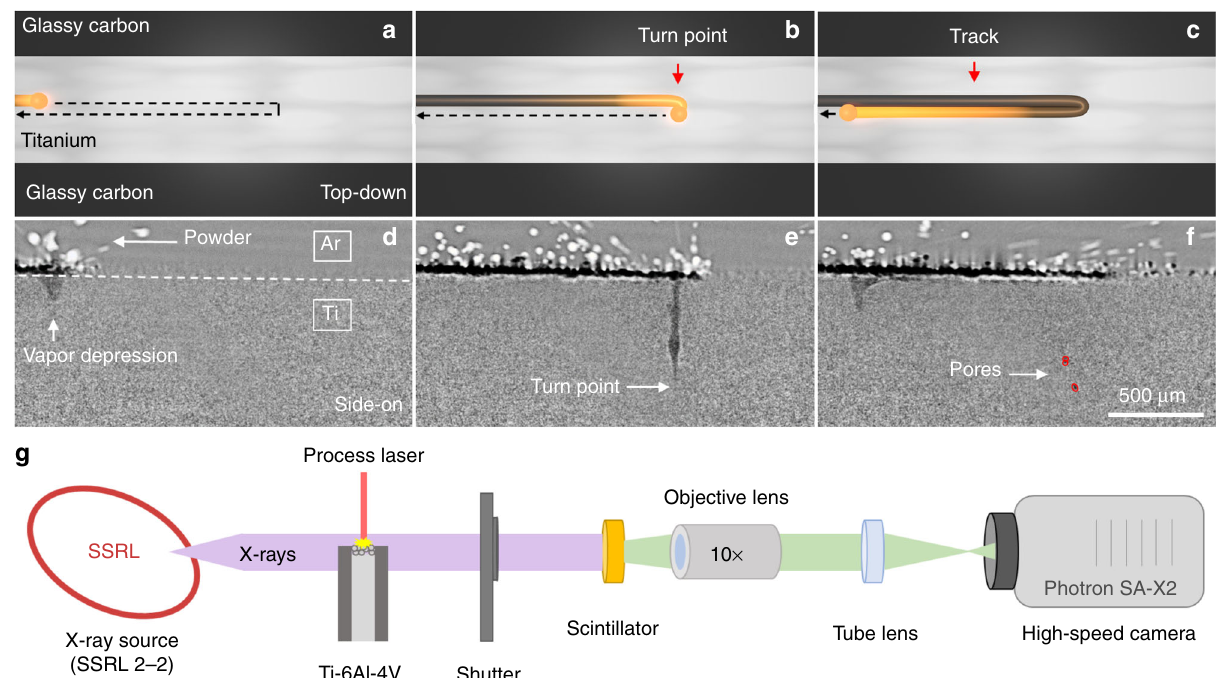
Fig. 1 Description of a laser turn point condition and experimental con fi guration. a – c A laser turn point is de fi ned as the condition during laser powder bed fusion (LPBF) where the laser reaches the end of a track, decelerates, shifts a prescribed hatch spacing, changes the scan direction by 180°, and then accelerates along a new track parallel and adjacent to the previous track. The black dashed line indicates laser trajectory. d – f Time difference ( t − t 0 ), transmission X-ray images of a turn point region in Ti – 6Al – 4V performed at a laser power of 200 W, and scan speed of 1000 mm s − 1 . d The laser is scanning from the left to right with spatter and powder motion above the substrate surface and a depression in the surface of the melt pool due to vapor recoil below. The titanium – argon interface is indicated by the white dashed line. e The laser enters the turn point region and shifts by the prescribed hatch spacing. f The laser is moving right to left after the turn point forming a new adjacent track and leaving behind keyhole pores. g Simpli fi ed schematic of the experiment con fi guration. A white-beam X-ray source is provided by experimental station 2 – 2 at the Stanford Synchrotron Radiation Lightsource (SSRL). The X-ray fi eld of view is coincident with the 1070 nm processing laser at the Ti – 6Al – 4V substrate surface. Images are captured using a scintillator-based